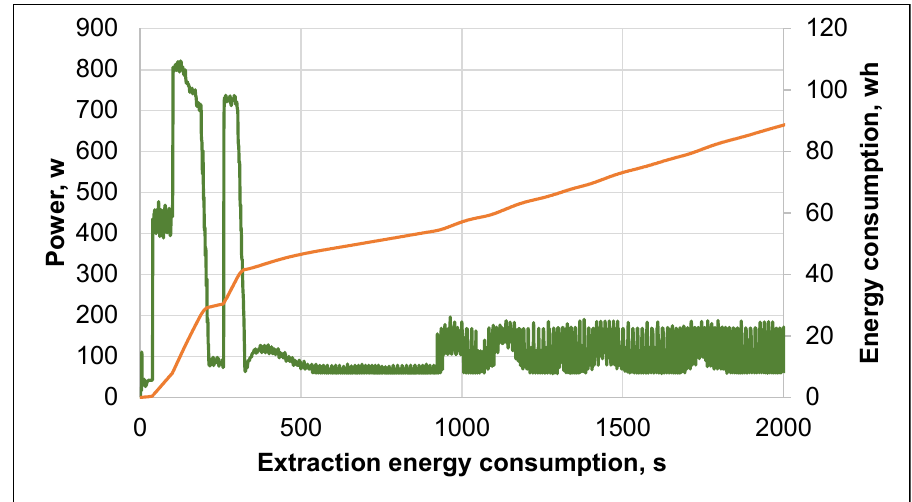
Figure 10. Measurement of energy consumption at 70 °C temperature for black alder bark deionized water extraction. These data were used as a basis for calculating the energy consumption to produce one unit of the extract at specified temperatures (see Table 4). The table shows that the energy consumption per unit of the extract does not change at temperatures of 130 °C and 150 °C, but up to 130 °C, it increases. Table 4. Black alder bark accelerated solvent extraction with deionized water energy consumption. Temperature, °C